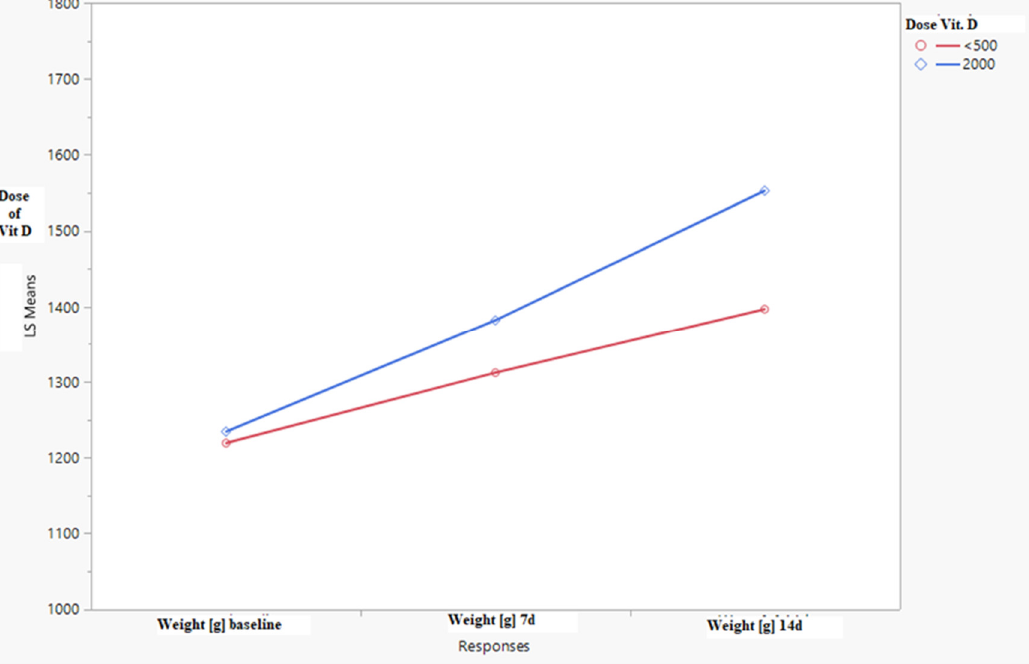
Figure 1. Fetal weights at the moment of inclusion into the study, after 7 and 14 d of observation depending on vitamin D dose.